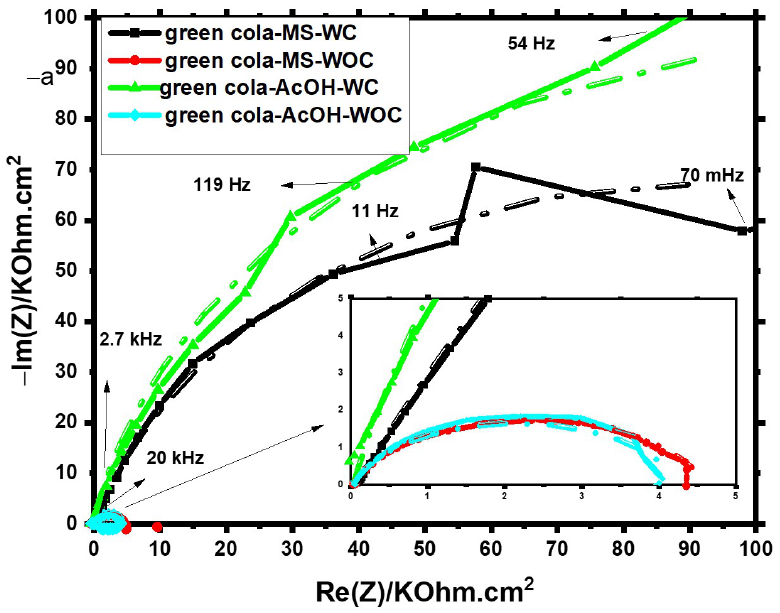
Figure 3. The Nyquist diagram for the Green Cola samples in main and acetic acid [0.1 M] solutions with (WC) and without (WOC) an organic coating; dash dot lines represent fitting according to Figure 5.